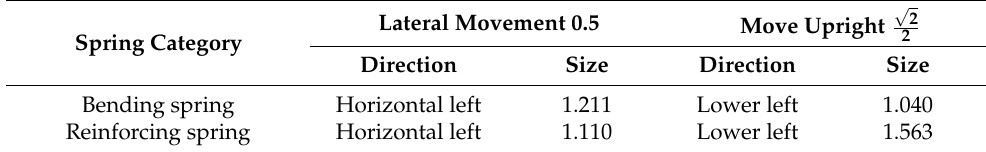
Table 1. Comparison of the force of bending and reinforcing spring on particle change.